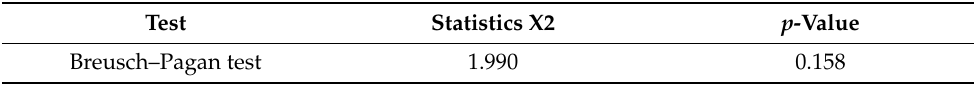
Table A6. The results of the variance heterogeneity test of the first model.